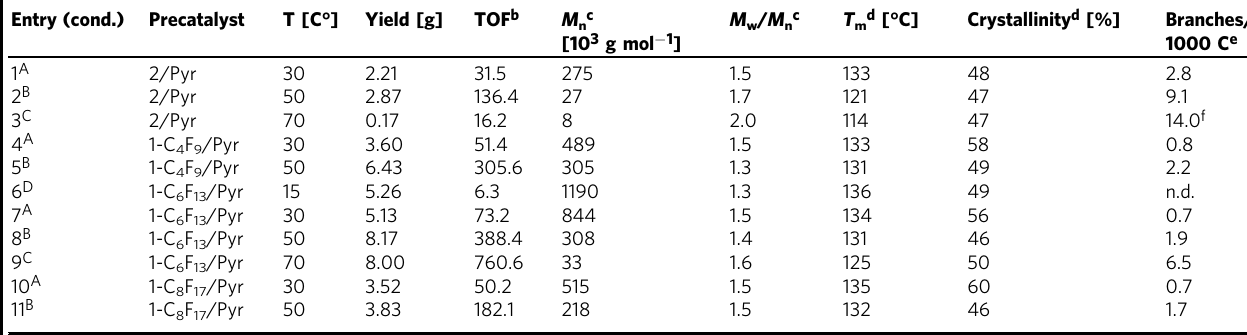
Entry (cond.) Precatalyst